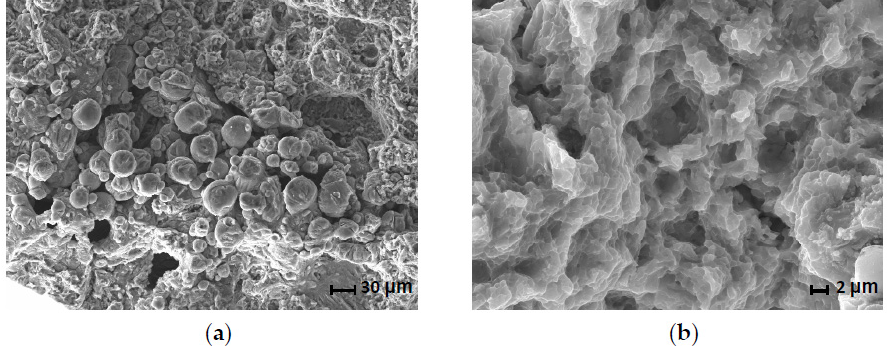
Figure 10. Fracture surface of sample 6-1: ( a ) unmelted powder particles and pores; ( b ) fine dimple morphology, powder particle.